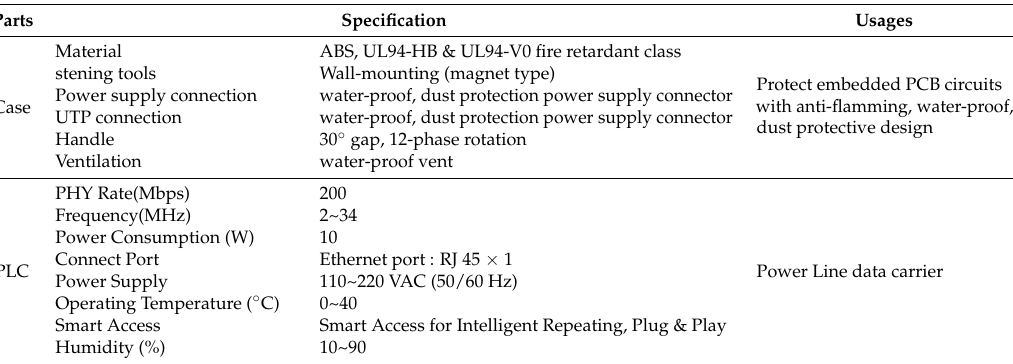
Table 2. Specifications of the PLC repeater.